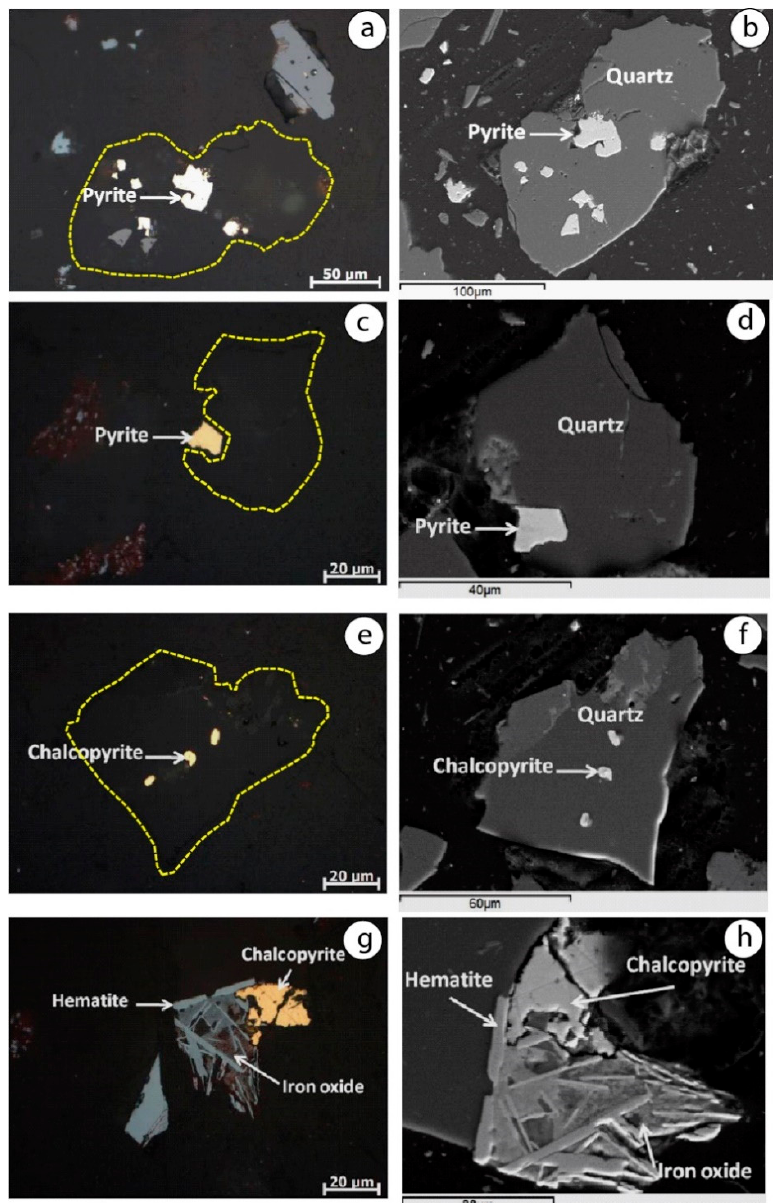
Figure 6. The identified sulfide minerals within the desulfurized tailings obtained from the flotation test; optical microscopy ( a , c , e , g ) and SEM ( b , d , f , h ). test; optical microscopy ( a , c , e , g ) and SEM ( b , d , f , h